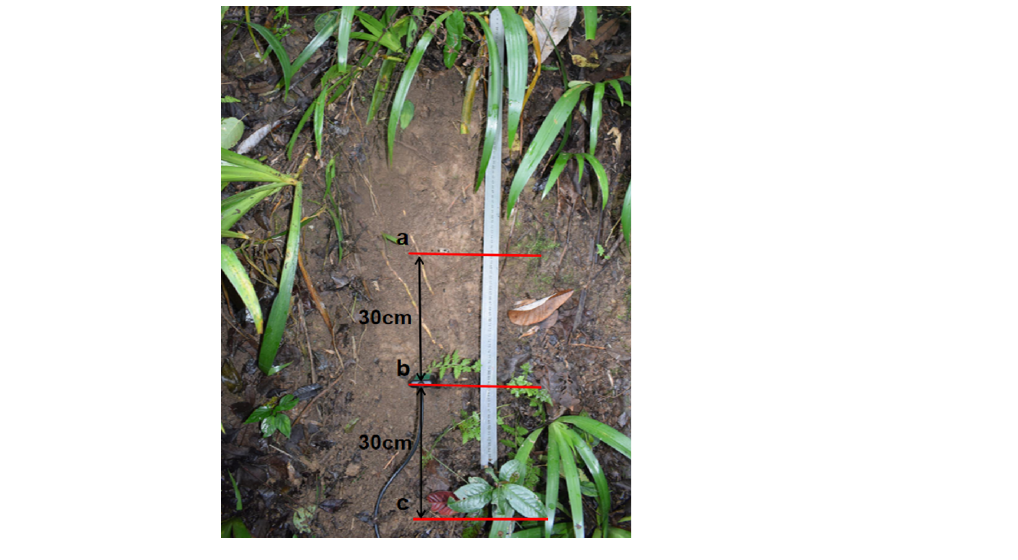
Figure 8. Soil moisture measurement in Longxi River Basin.